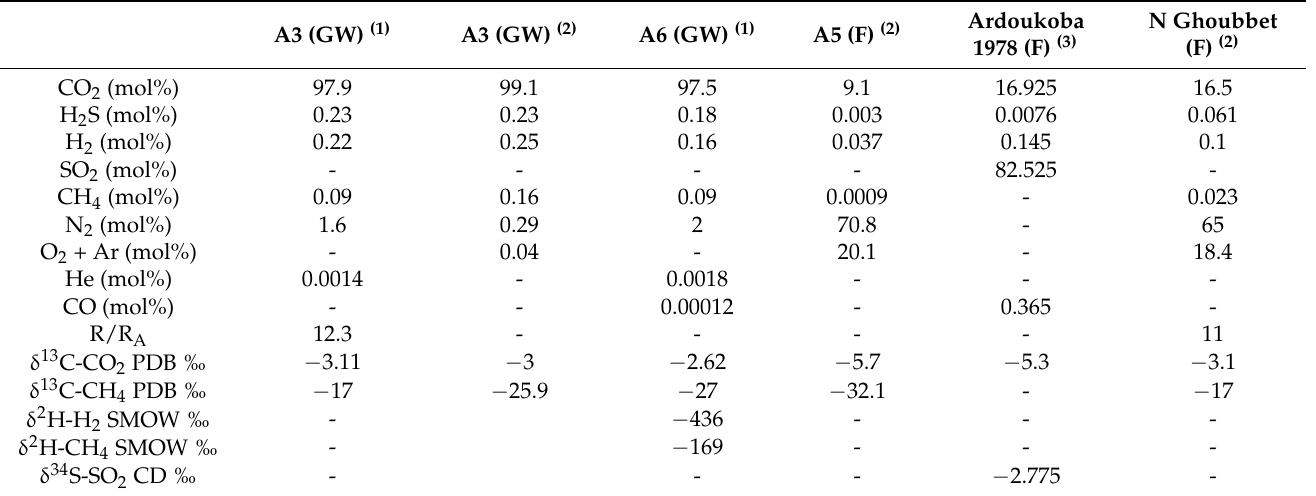
Table 1. Gas composition and isotopic data from Asal wells and fumaroles. GW: geothermal well; F: